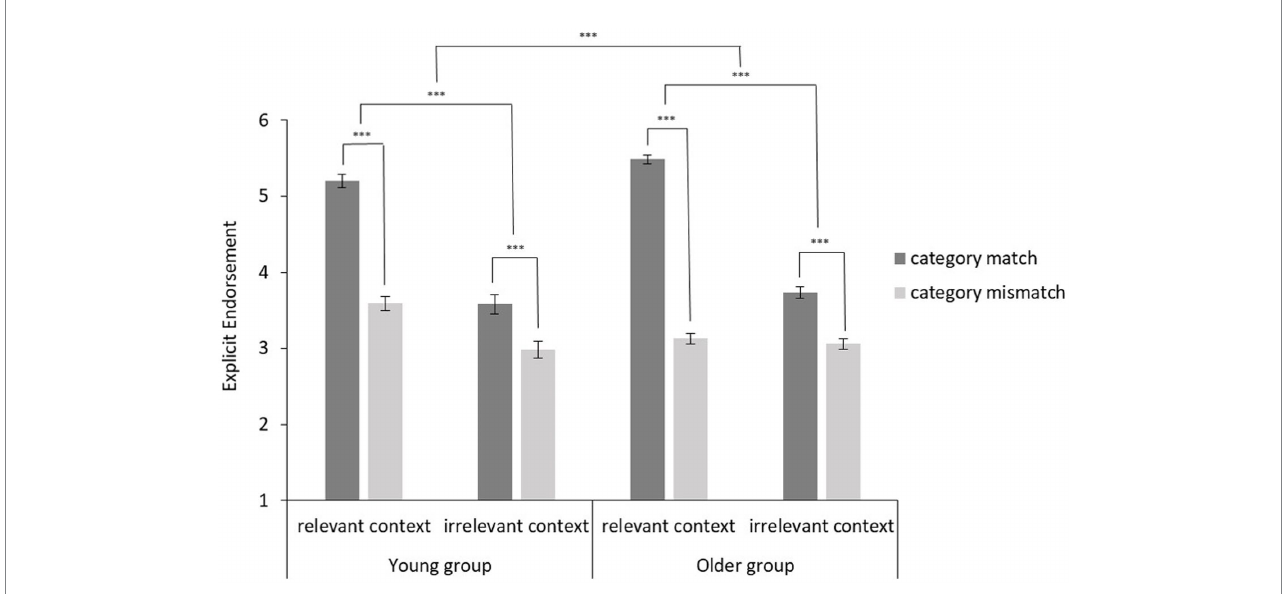
FIGURE 3 Explicit endorsement (error bars indicate standard errors) of age stereotypes depending on the category and context information in the statement and age group. *** p < 0.001.